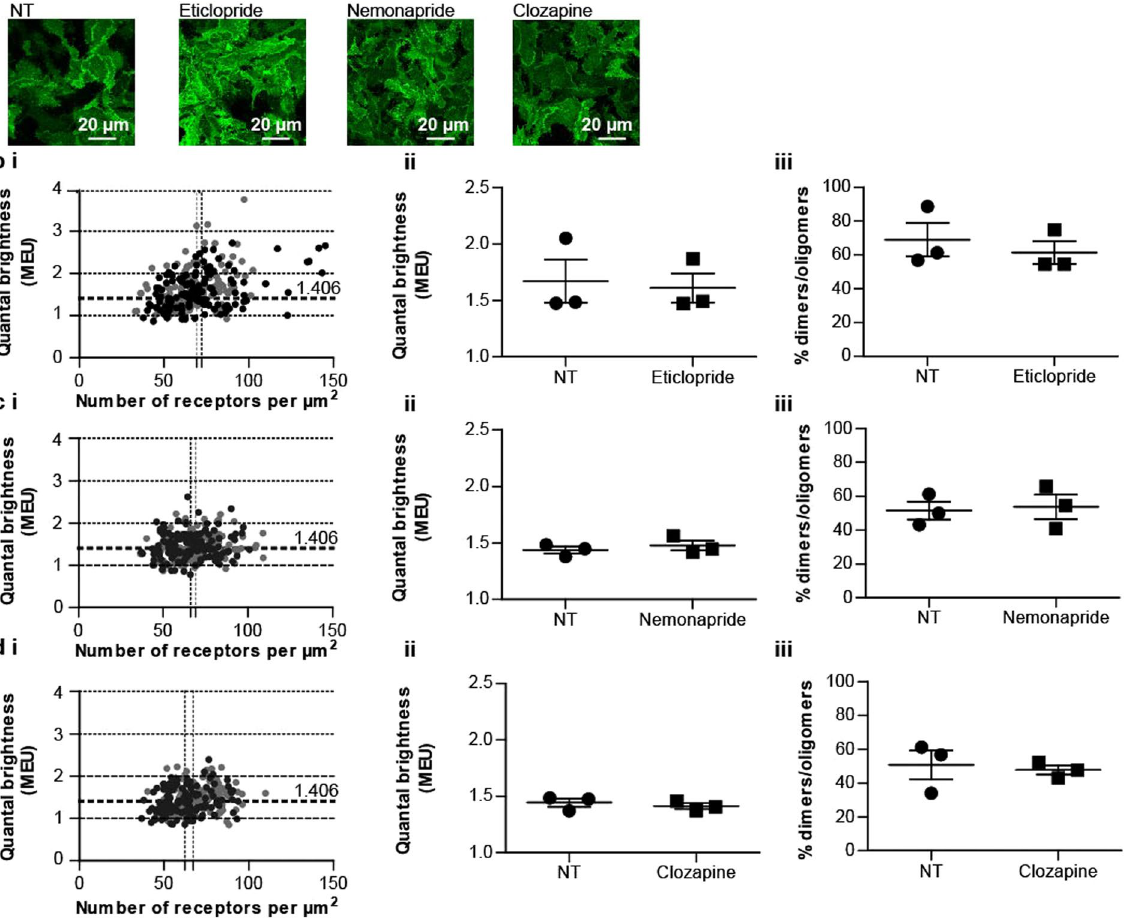
Figure 7. Treatment with eticlopride, nemonapride or clozapine does not alter the quaternary organization of hD 3 R. Flp-In T-REx 293 hD 3 R-mEGFP clone 2 cells were untreated or treated with eticlopride, nemonapride or clozapine as described in Fig. 6. ( a ) Confocal images from the basolateral membrane of cells not treated (NT) or those treated with eticlopride, nemonapride, or clozapine were collected with laser power set at 6%. Scale bar = 20 μ m. QB MEU were assessed in individual RoI and plotted against the number of hD 3 R-mEGFP per µ m 2 at the cell surface. Light grey circles , untreated cells (NT); Black circles , cells treated with eticlopride ( b(i) ), nemonapride (c(i) ), or clozapine ( d ( i )). Quaternary organization of hD 3 R–mEGFP receptor was expressed as QB MEU value and was equal to 1.67 ± 0.19 and 1.61 ± 0.13 in vehicle- and eticlopride- treated cells, respectively ( b ( ii )); to 1.44 ± 0.03 and 1.48 ± 0.04 in vehicle- and nemonapride treated cells, respectively ( c ( ii )) and to 1.44 ± 0.04 and 1.41 ± 0.02 in vehicle- and clozapine treated cells, respectively ( d ( ii )). RoIs containing predominantly dimers/oligomers were found to be equal to 68.9 ± 10.0 and 61.4 ± 6.8 in vehicle- and eticlopride treated cells, respectively ( b ( iii )); to 51.5 ± 5.3 and 53.8 ± 7.2 in vehicle- and nemonapride treated cells, respectively ( c ( iii )) and to 50.8 ± 8.4 and 47.7 ± 2.6 in vehicle- and clozapine treated cells, respectively ( d ( iii) ). Combined data each from n = 3 × 44 experiments, with the average value from each experiment shown, error bars represent ±